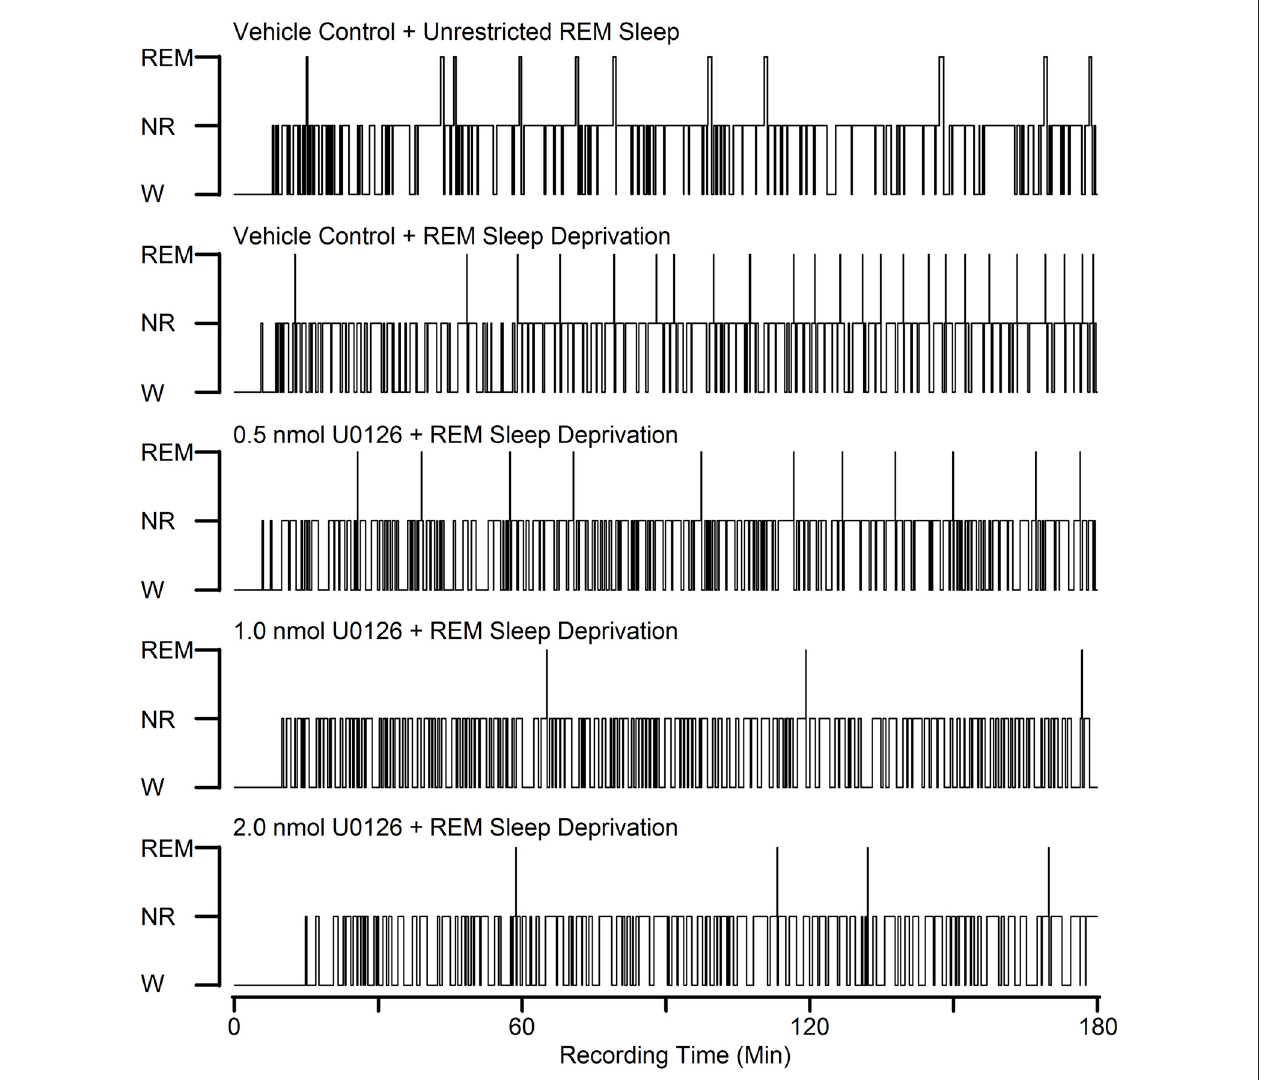
FIGURE 2 | Examples to show the effects of bilateral microinjections of different doses of U0126 into the PPT on sleep-wake architecture during selective REM sleep deprivation. These five hypnograms from five different rats plotted as step histograms plot the occurrence and duration of polygraphically defined wakefulness (W), non-REM sleep (NR), and REM sleep after vehicle control and three different doses of U0126. All microinjections were made at 10:00 A.M. and were followed by 3 h recording session. Note increased REM sleep homeostatic drive (RSHD; progressively increased attempt to REM sleep) in animals treated with vehicle control and selective REM sleep deprivation compared to the vehicle control and unrestricted REM sleep. Also note that the numbers of REM sleep episodes in the U0126-treated rats are reduced compared to the vehicle control and selective REM sleep deprived